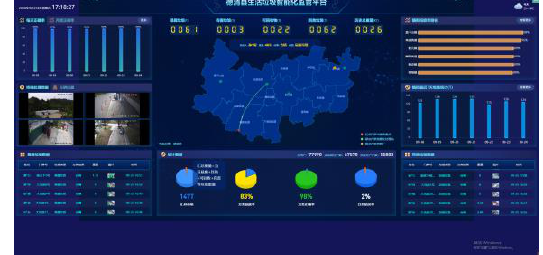
Figure 3 . Intelligent supervision platform for household garbage by Smart Deqing.